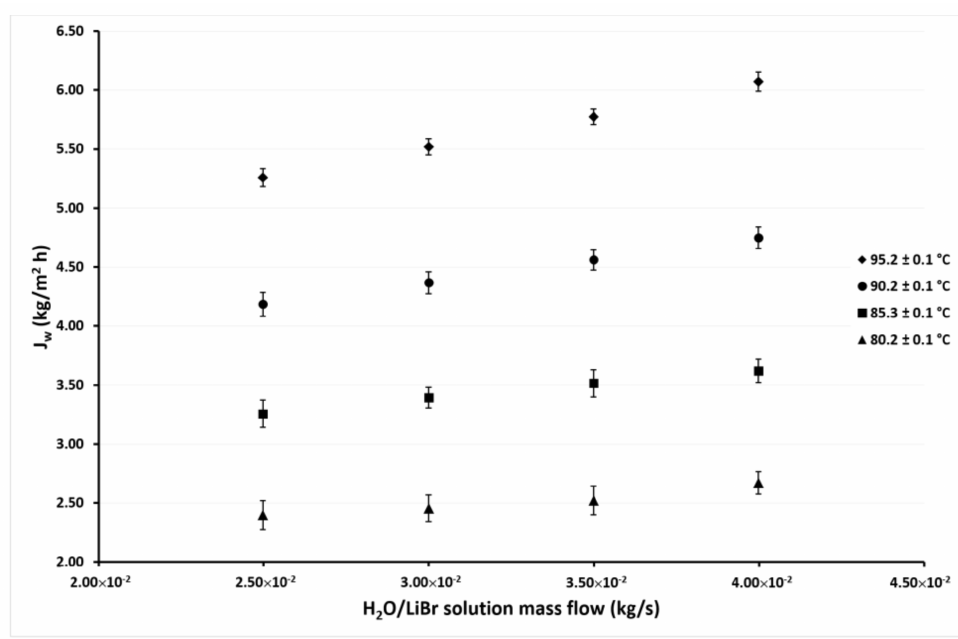
Figure 8. Desorption rate as a function of the ˙m LiBr with T cw,in = 30.1 ± 0.1 ◦